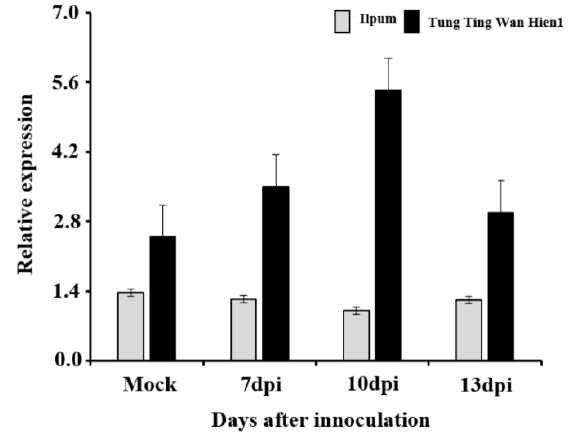
Figure 2. Transcript accumulation patterns of OsPR1a (Os07g03710) in resistant and susceptible rice varieties inoculated with Fusarium fujikuroi CF283 isolate. Bars (white: Ilpum and black: Tung Ting Wan Hien1) are mean values ± SD. The expression values of the target genes were normalized to that of the housekeeping gene, ubiquitin 5 ( UBQ5 ).